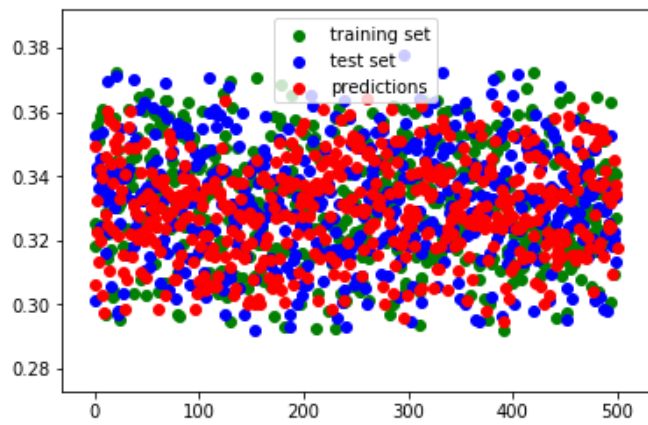
Figure 10. Scatter plot of norm predictions and ground-truth. X axis refers to a certain image number. Y axis is the norm value. The norm of predicted matrices are very close to the training and test set ground-truth